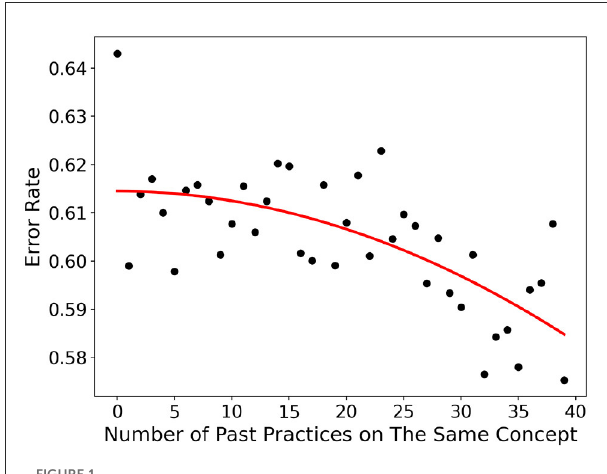
FIGURE1 The “learning curve” in